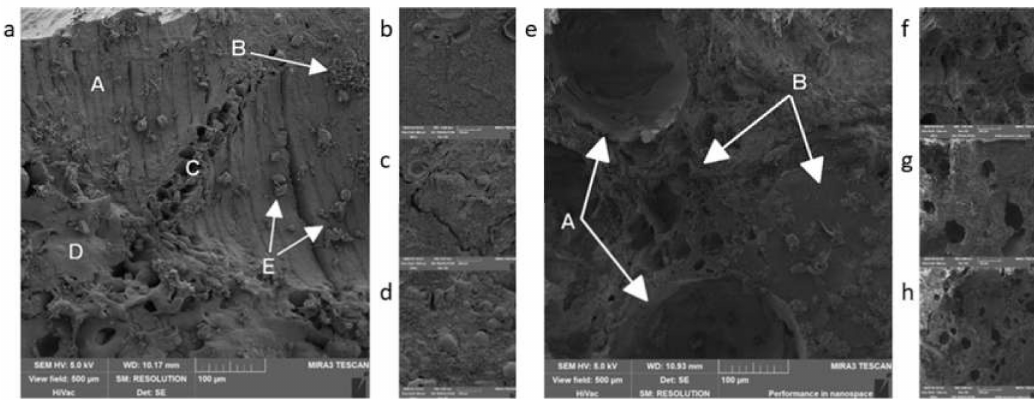
Figure 5. Long-life heat-treated meat products: ( a , b )—“Tourist” salami, procedure 1, A—muscle fibers, B—artifacts, C—connective tissue, D—spilled, fixed fat, E—crystals- artifacts; ( c , d )—“Vysoˇcina”, procedure 1; ( e , f )—“Vysoˇcina”, procedure 2, A—empty gaps after fat droplets, B—connection; ( g , h )—Tourist salami, procedure 2.